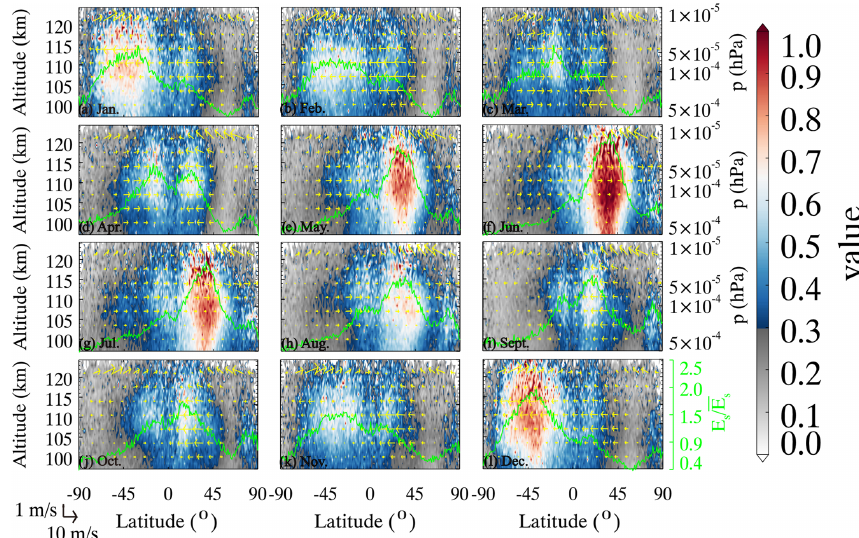
Figure 3. Monthly variation in the E s layer intensity represented by the S4max index from COSMIC, with superposed ion drifts from the model caused by residual meridional circulations. The monthly mean variations in E s layers are shown for different altitudes and latitudes from 2006 to 2011. The solid green lines are the ratios of column densities at different latitudes to the global mean column density. The yellow arrows between altitudes of 100–120km show the predicted vertical and meridional velocity of ion drift (vectors with a scale of 1m · s − 1 / 10m · s − 1 ), driven by the atmospheric meridional circulations from the